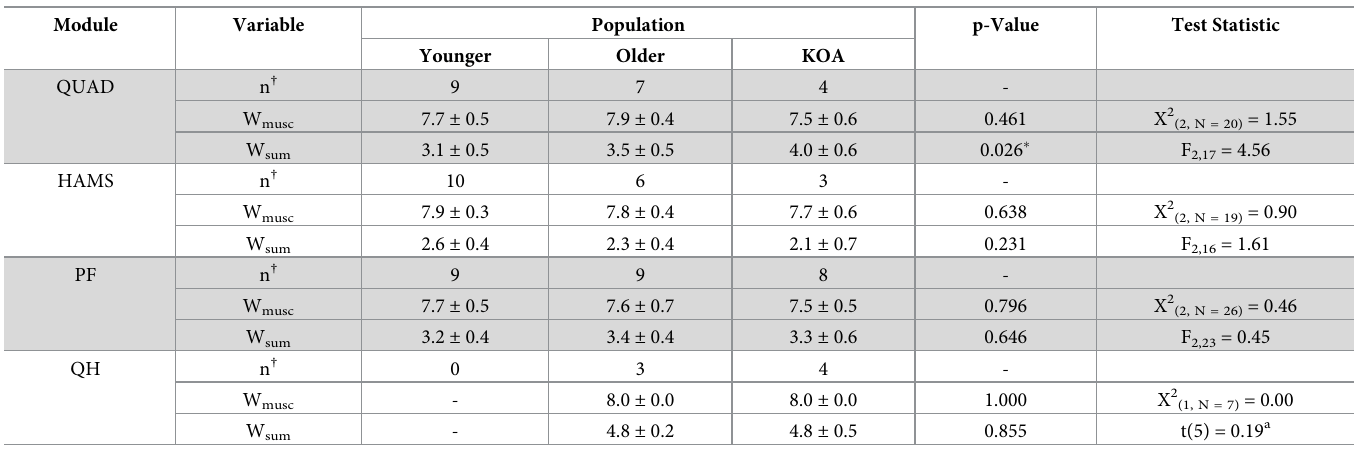
Table 4. W musc and W sum for common modules.